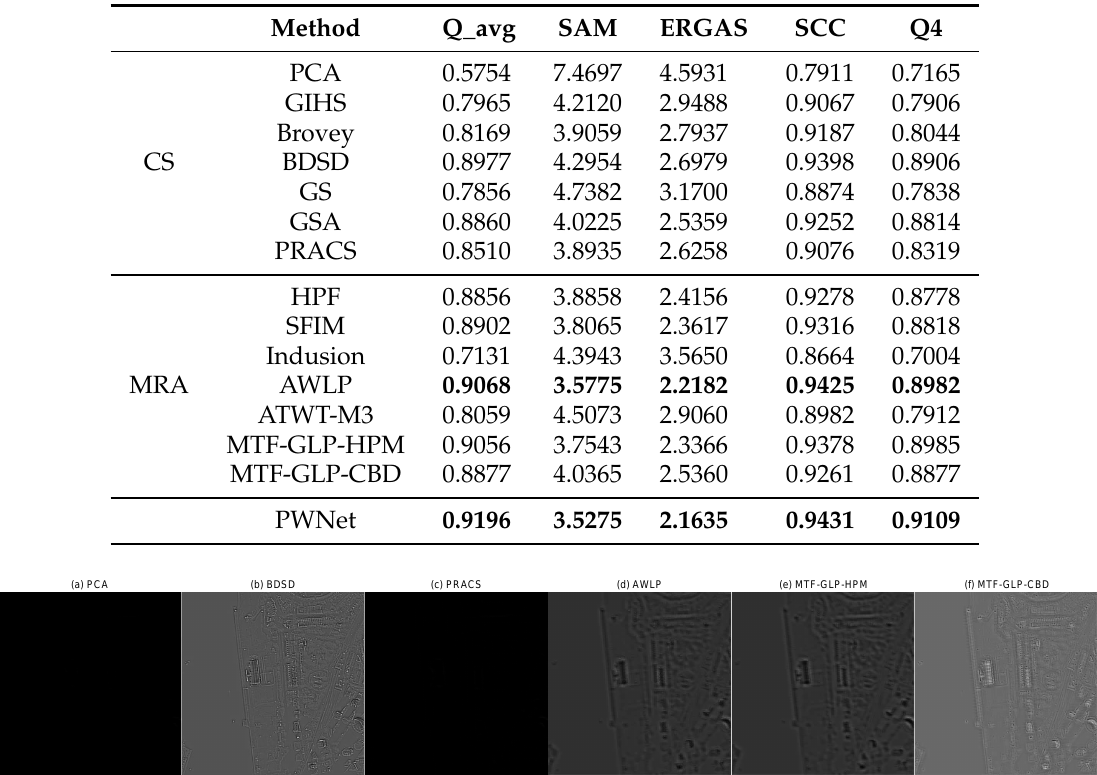
Figure 8. Visualization of weight maps on the WorldView-2 images, ( a ) PCA; ( b ) BDSD; ( c ) PRACS;